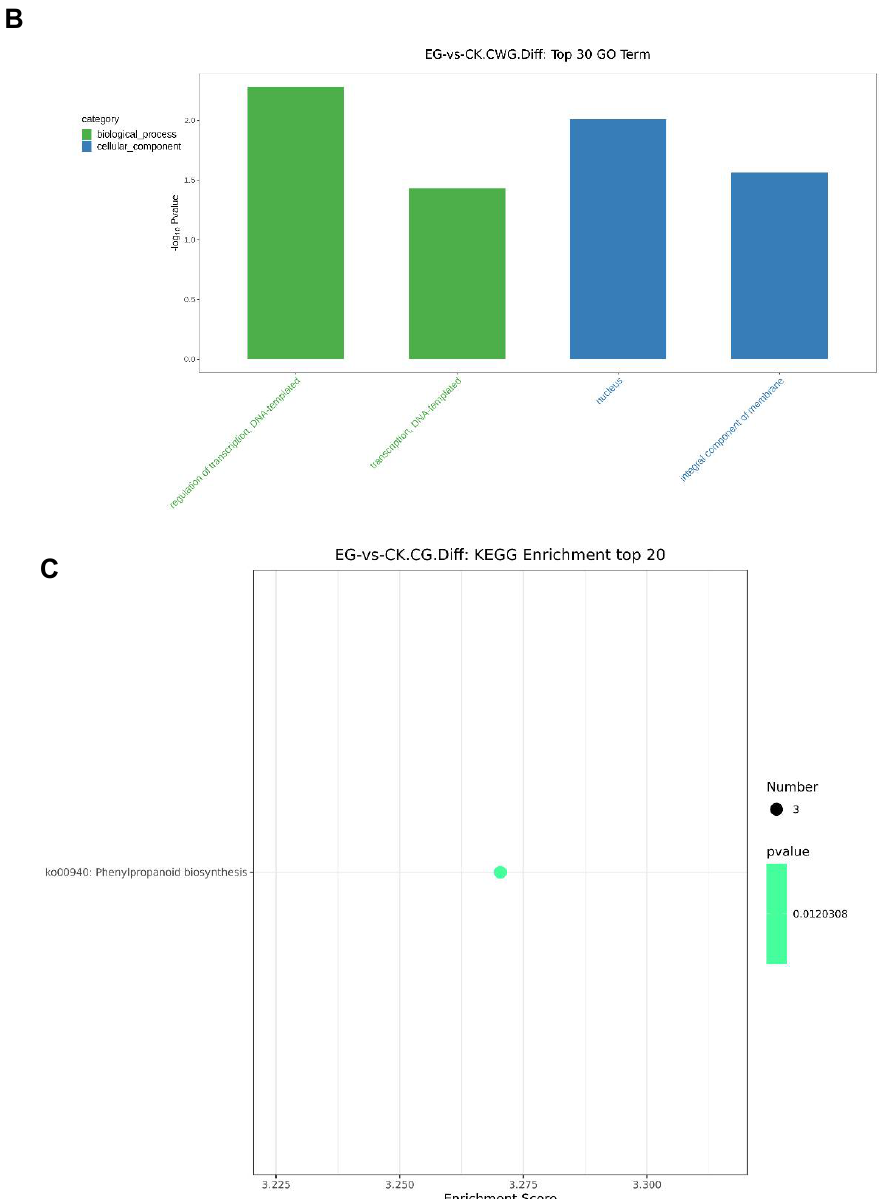
Figure 11. The top 30 GO functions and the top 20 KEGG of the DMGs at the mCG and mCWG sites. ( A ) The top 30 differentials GO terms at mCG sites; ( B ) the top 30 differentials GO terms at mCG sites; The X coordinates in the figure are the name of the GO entry, and the Y coordinates are − log10Pvalue. The green, blue and red colors represent biological process, cellular component, and molecular functions, respectively, ( C ) the top 20 KEGG enrichment. The x -axis is the enrichment score, and the y -axis is the KEGG enrichment. The bubble represents gene entries; the larger the bubble, the more entries it contains and the more differential protein-coding genes. The bubble color green denotes the p-value, and the smaller the enrichment value, the greater the significance.